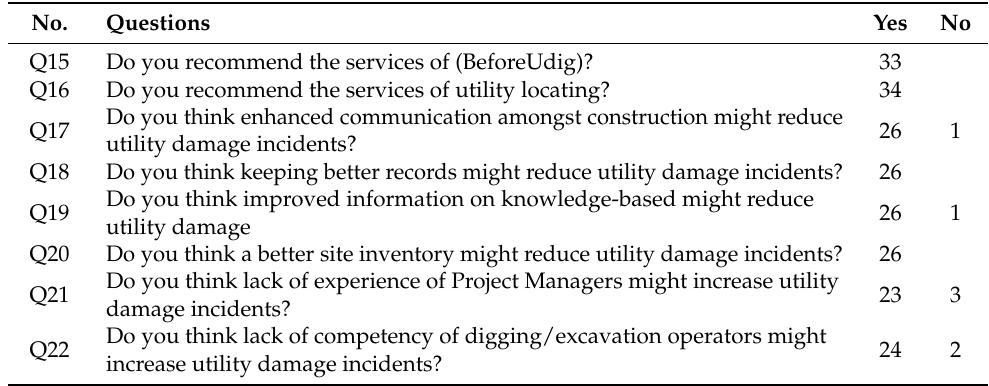
Table 2. Breakdown of binary